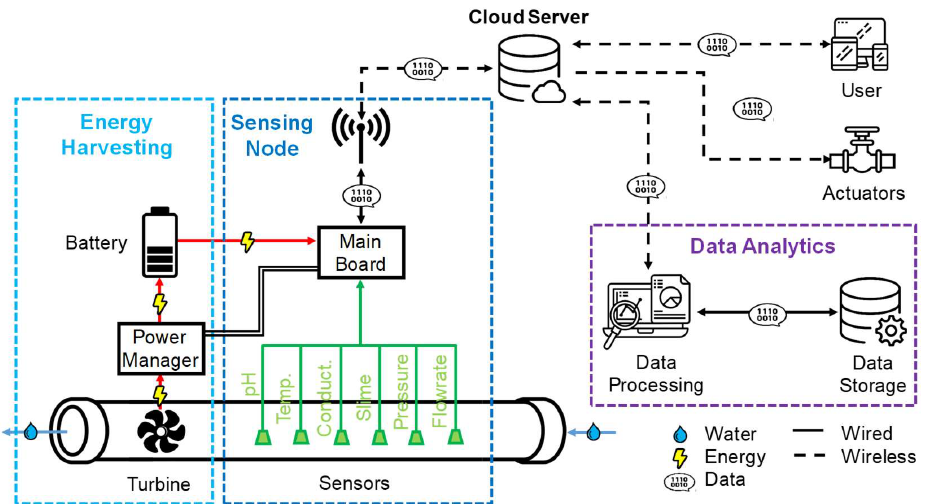
Figure 1. The architecture of the proposed network composed of sensing nodes (monitoring 6 chemo-physical water parameters) powered by kinetic energy harvesting and connected through long-range radio links to a Cloud server, providing visualization, feedback control, and analytics.